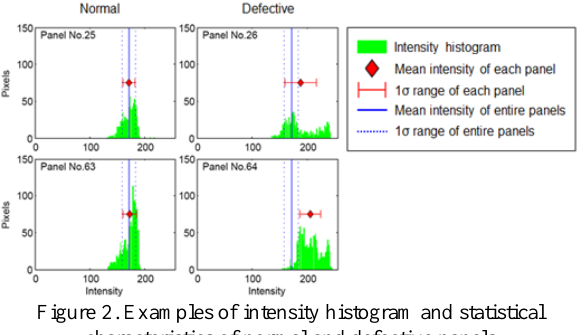
Figure 2. Examples of intensity histogram and statistical characteristics of normal and defective panels The histograms on the left side in Figure 2 represent normal panels (25 and 63), and those on the right side represent defective panels (26 and 64). Because intensity distributions of normal panels are similar to those of adjacent panels, normal panels close to panels with hot spots were selected for comparison. The blue solid and dotted lines in Figure 2 represent the mean intensity and standard deviation range, respectively, of pixels in the entire panel area. The red diamond and solid line represent the mean intensity and standard deviation range, respectively, of the pixels in each panel area concerned. The normal panel histograms are distributed at an intensity range of 200 or lower and display patterns similar to the normal distribution of the entire panel area. In contrast, the defective panel histograms contain pixels with intensity values exceeding 200 and display multiple peaks that deviate from a normal distribution. Comparison of the mean intensity and standard deviation range of each panel revealed that while normal panels displayed values similar to the standard deviation range of the entire panel area, defective panels displayed higher values. This result is attributable to the increased intensity distribution range caused by the hot spots present on defective panels, resulting in a larger standard